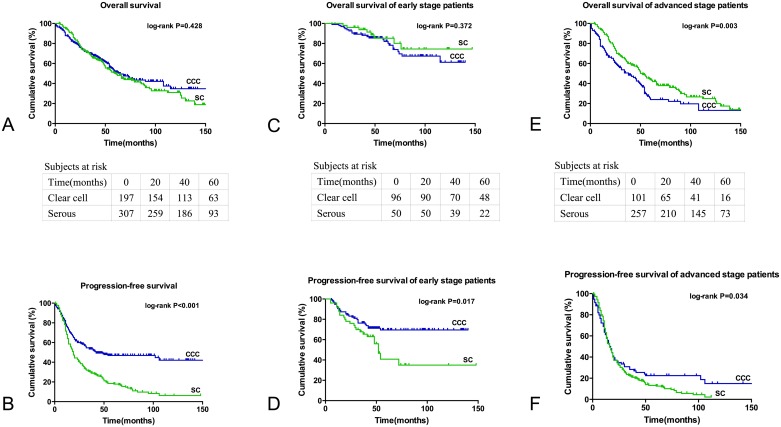
Kaplan-Meier survival curves of patients with ovarian clear cell carcinoma (CCC) and serous carcinoma (SC).Fig 1A and 1B show the OS and PFS of CCC and SC, respectively. Fig 1C and 1D show the survival curves of patients with early-stage disease, and Fig 1E and 1F show the survival curves of patients with late-stage disease.